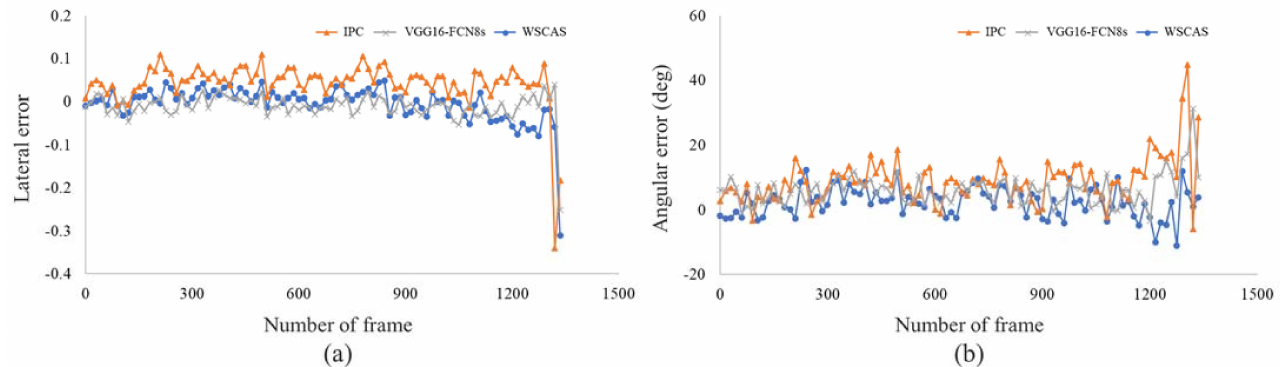
Figure 8. Lateral ( a ) and angular ( b ) errors of the estimated uncut crop edge for path